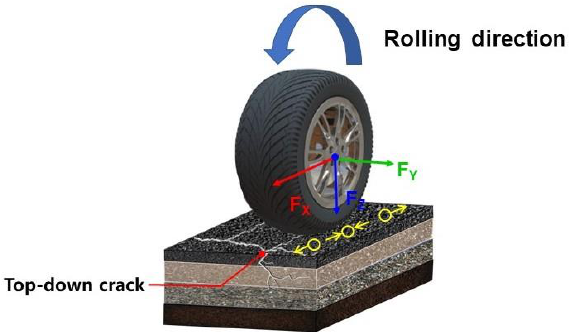
Figure 1. Tire-pavement contact interaction.